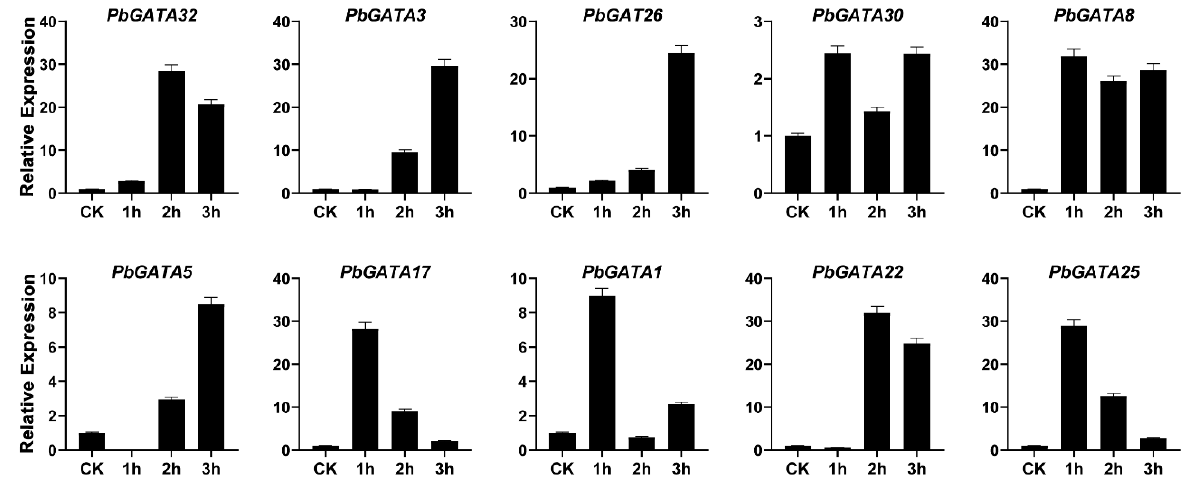
Figure 11. Expression profiling of GATA gene family analyzed by qRT-PCR in the fruit of Chinese pear at the developmental stage after hormonal treatment of abs cis ic acid (ABA) and CK represents control. Error bars represent the standard error (SE) of three biological replicates.